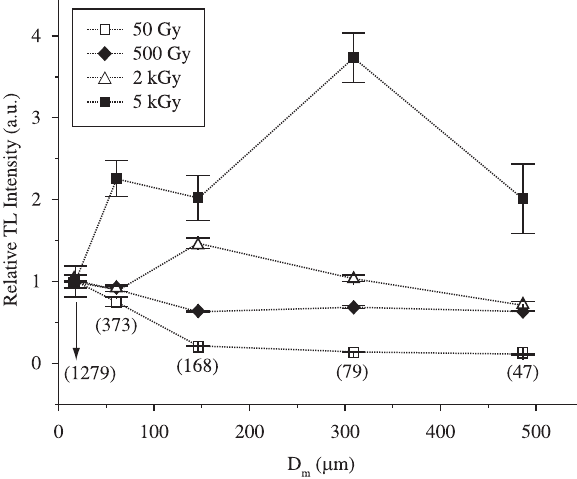
Figure 2. Relationship between TL intensity integrated from 175 to 390 °C and the mean particle size ( D ) for non-sensitized quartz. Values between m parentheses are the specific surface area measured in cm 2 g –1 .